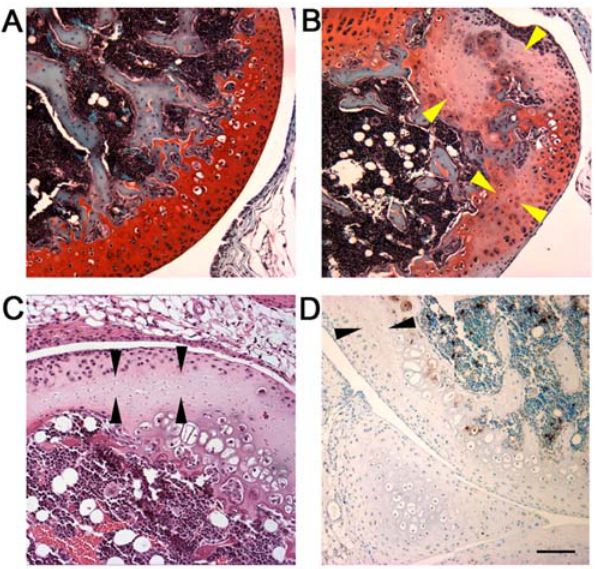
Figure 4. Chondronecrosis in the articular cartilage of Trsp fl/fl Col2a1-Cre mice. (A) Triple-stained section of the femoral articular cartilage of a Trsp fl/fl control mouse; the red staining reveals the presence of glycosaminoglycans in the extracellular matrix surrounding the embedded chondrocytes. (B) Triple-stain of femoral articular cartilage from a representative Trsp fl/fl Col2a1-Cre mouse, showing marked glycosaminoglycan depletion (pale red regions) in the areas of chondronecrosis (arrowheads). (C) Hematoxylin and eosin-stained section of distal femoral articular cartilage from another Trsp fl/fl Col2a1-Cre mouse, showing a typical region of chondronecrosis (arrowheads). (D) TUNEL positive apoptotic cells (stained brown) lining an area of chondronecrosis (arrowheads) in the distal femoral articular cartilage of a Trsp fl/fl Col2a1-Cre mouse knee. Scale bar=110 m m.